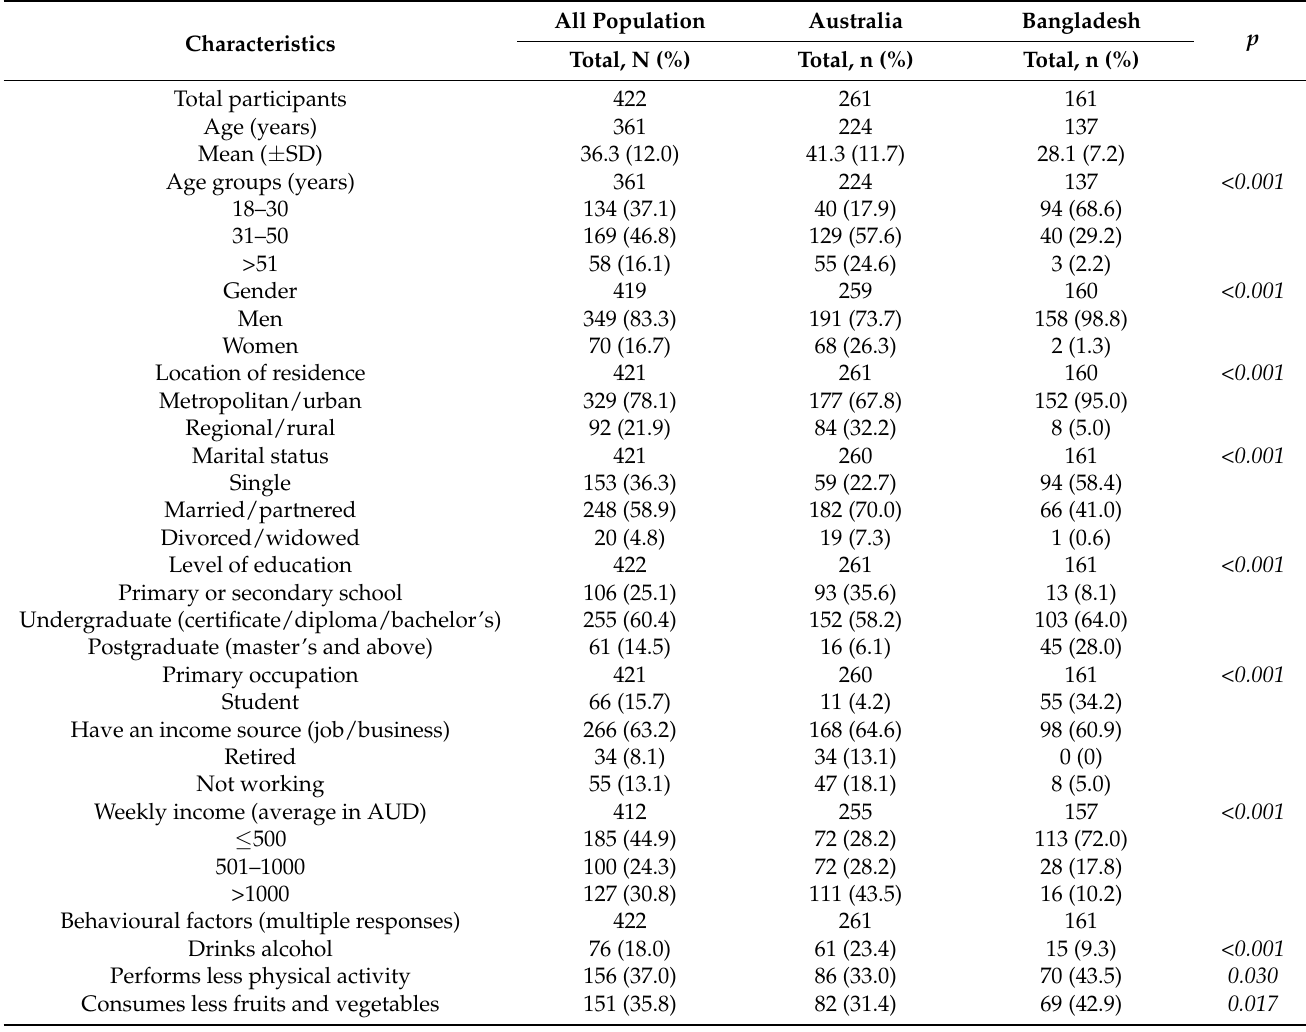
Table 1. Characteristics of the study